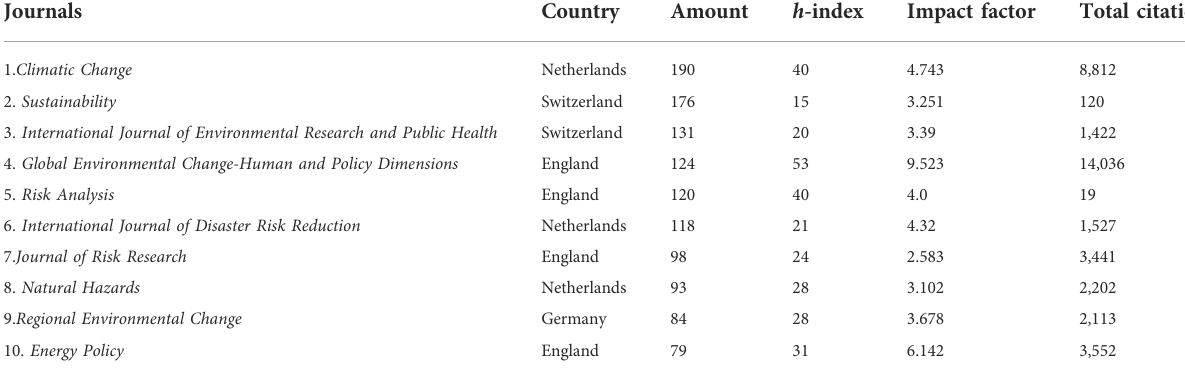
TABLE 2 The Primary performance of the top 10 most productive